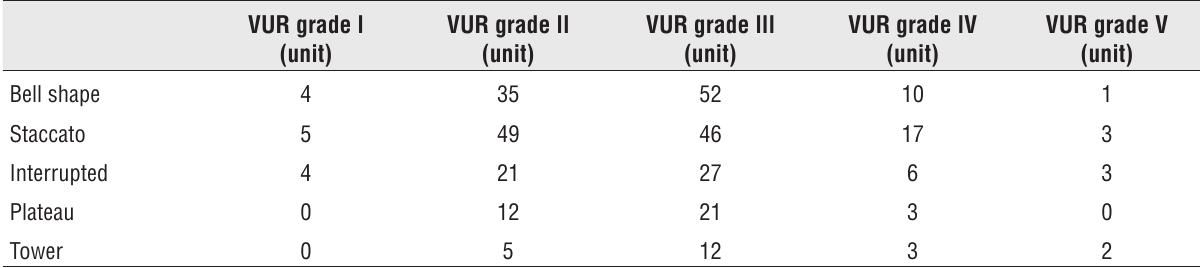
Table 4 - Grade of vUR in different urine flow